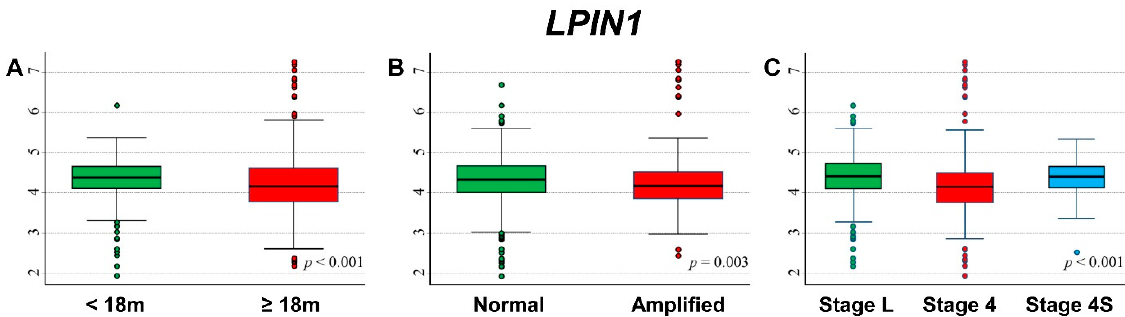
Figure 19. Association between LPIN1 gene expression and the main patient characteristics at diagnosis. ( A ) Age; ( B ) MYCN status; ( C )